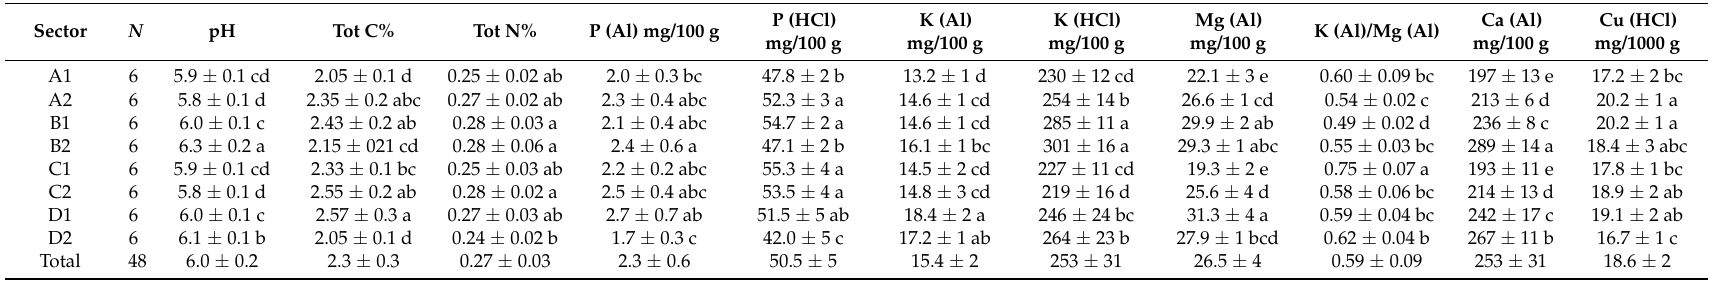
Table 2. Mean soil parameters in each of the eight sectors (A1–D2) within the field trial. Sampling date 10 September 2006. Means within the same column followed by different letters are significantly different according to one-way ANOVA with Duncan’s post hoc test ( p <